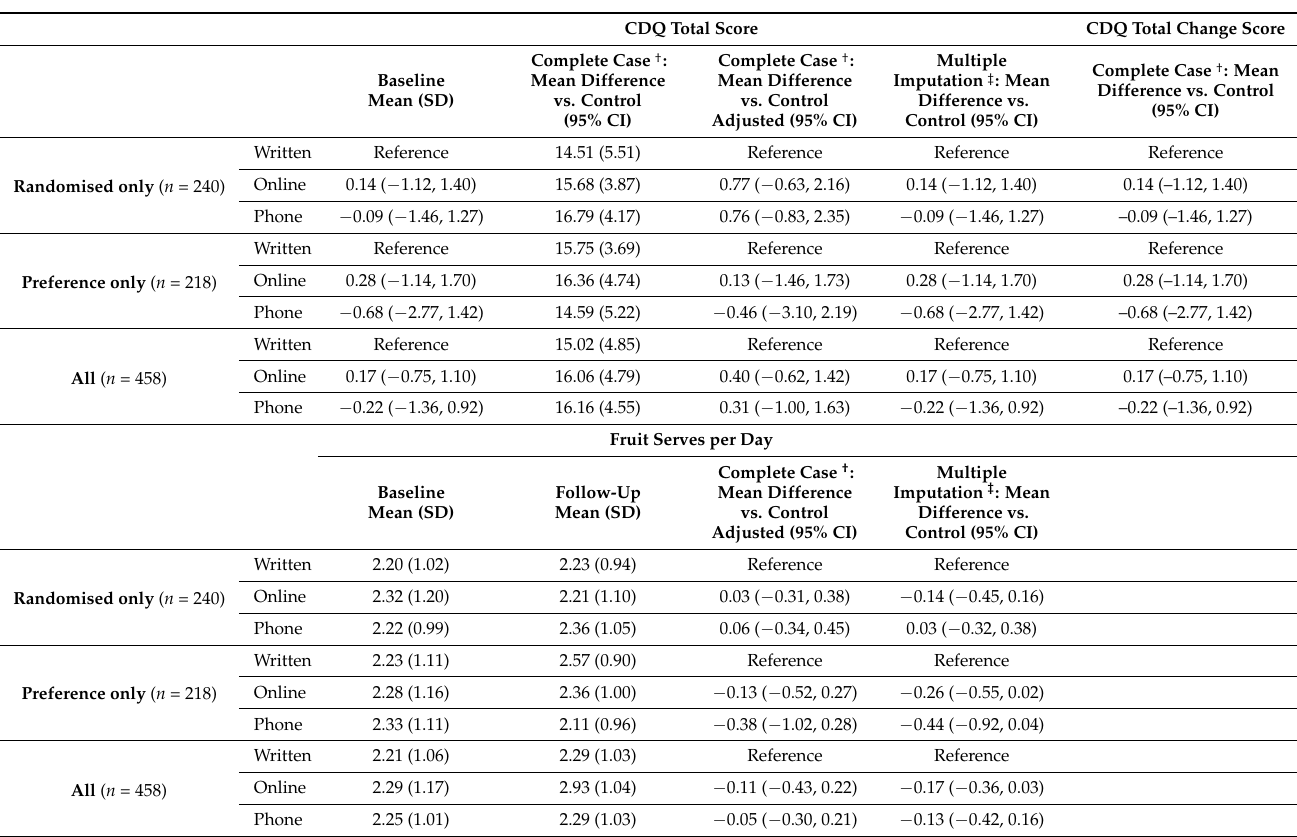
Table 2. Results for primary outcome by study group (CDQ score, fruit and vegetable daily intake, and meeting fruit and vegetable